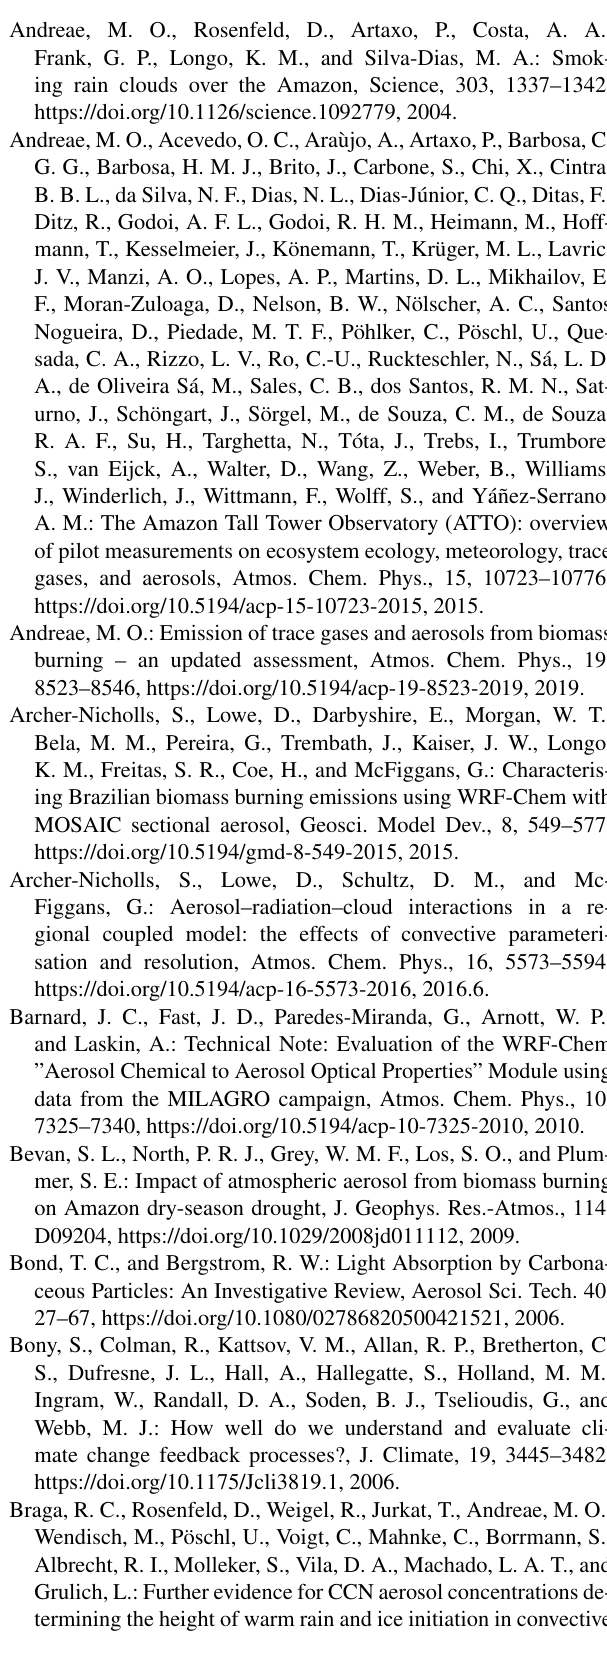
Figgans, G.: Aerosol–radiation–cloud interactions in a re- gional coupled model: the effects of convective parameteri- sation and resolution, Atmos. Chem. Phys., 16, 5573–5594,